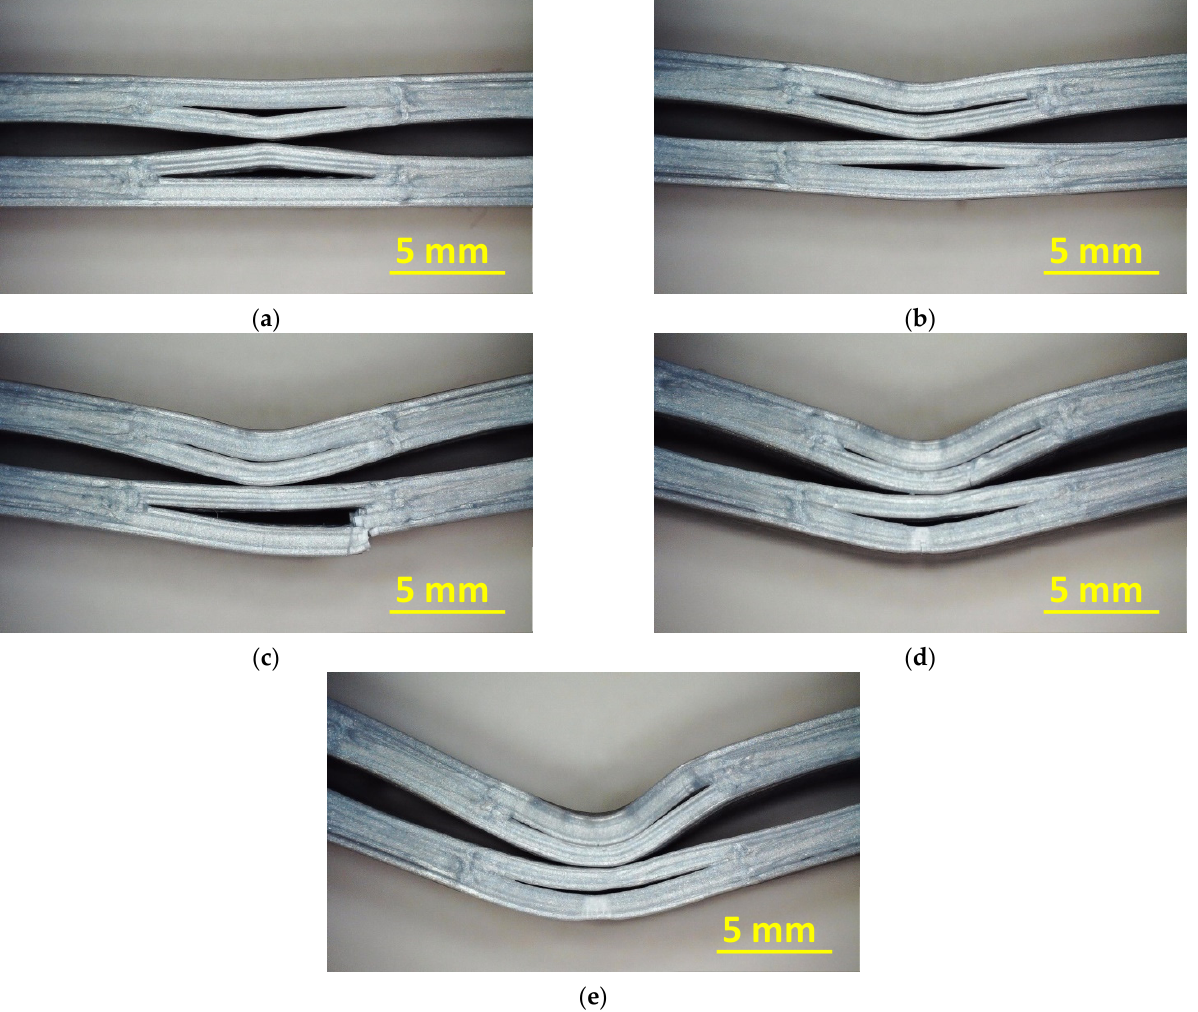
Figure 6. Microscopic images taken after 10 cycles of three-point bending and recovery tests of sample LP100, printed on the long edge, with different maximum deflections: ( a ) 5 mm; ( b ) 10 mm; ( c ) 15 mm; ( d ) 20 mm; and ( e ) 17.5 mm.